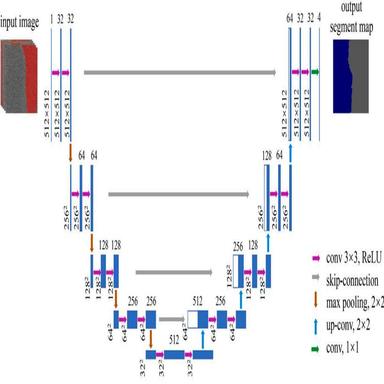
Flowchart of dendrite/Interdendritic recognition model based on U-Net.